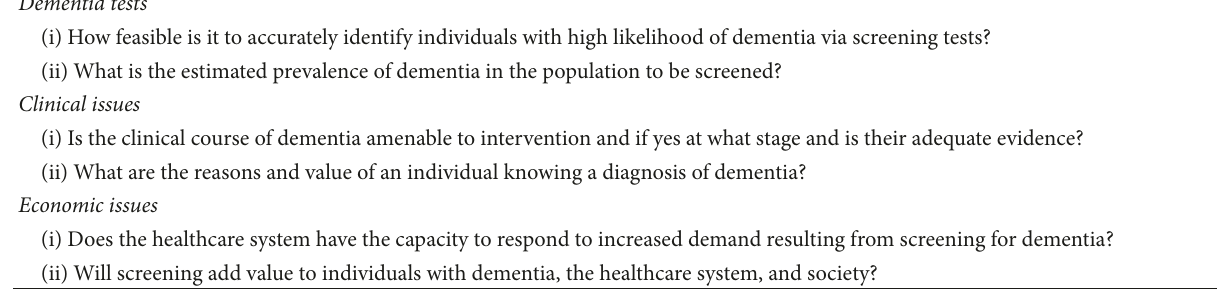
Table 1: Six testing, clinical, and economic conditions for determining whether screening for dementia among “apparently” healthy individuals does more good than